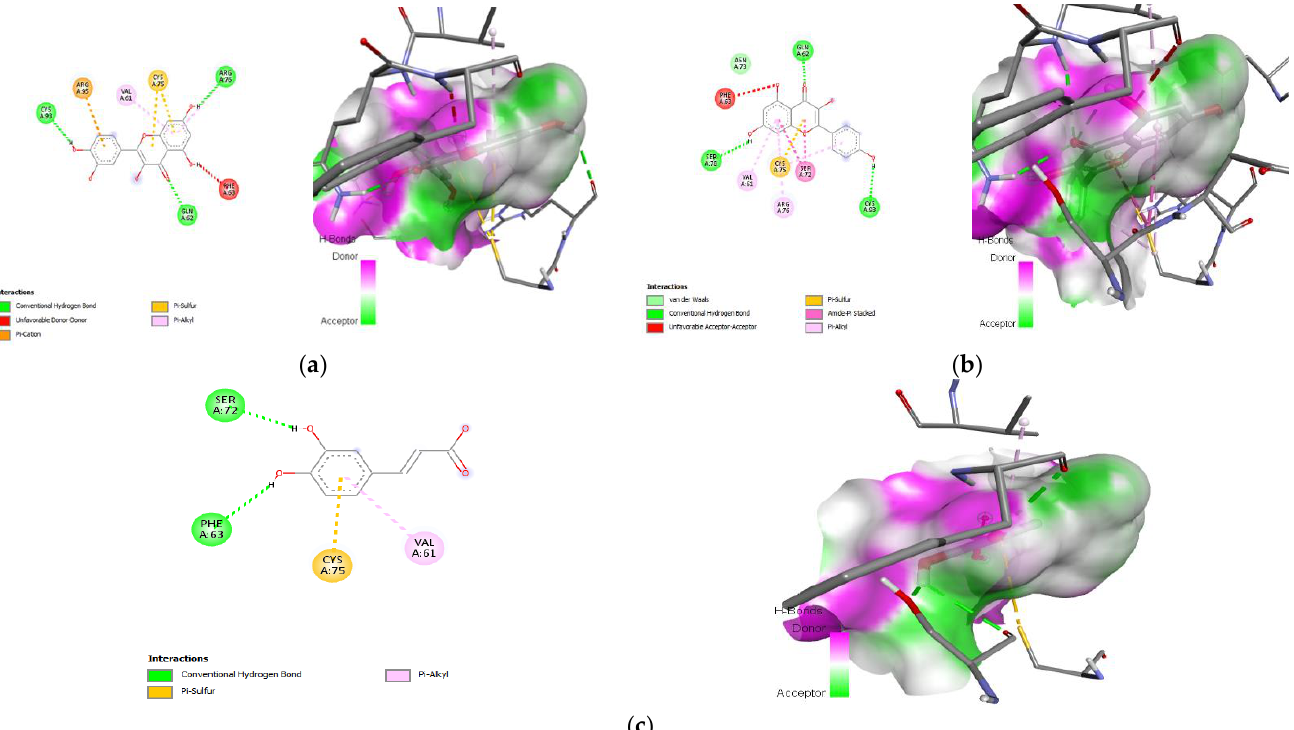
Figure 14. Lead compounds and their interaction with SREBP-1c at the molecular level. ( a ) Quercetin; ( b ) kaempferol; ( c ) caffeic acid .